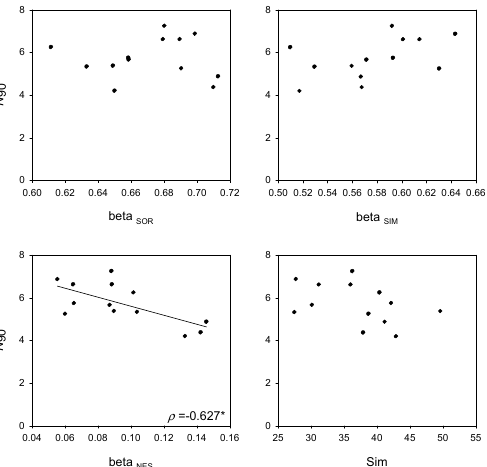
Figure 6. Results of the linear regressions analysis of N 90 with measures of beta diversity β SOR , β SIM and β NES and within-group similarity ( Sim ) considering the middle slope stratum (501–800 m depth). Spearman’s rank correlation coefficient ( ρ ) and p -values are presented. (*) p < 0.05; (**) p < 0.01; (***) p < 0.001.